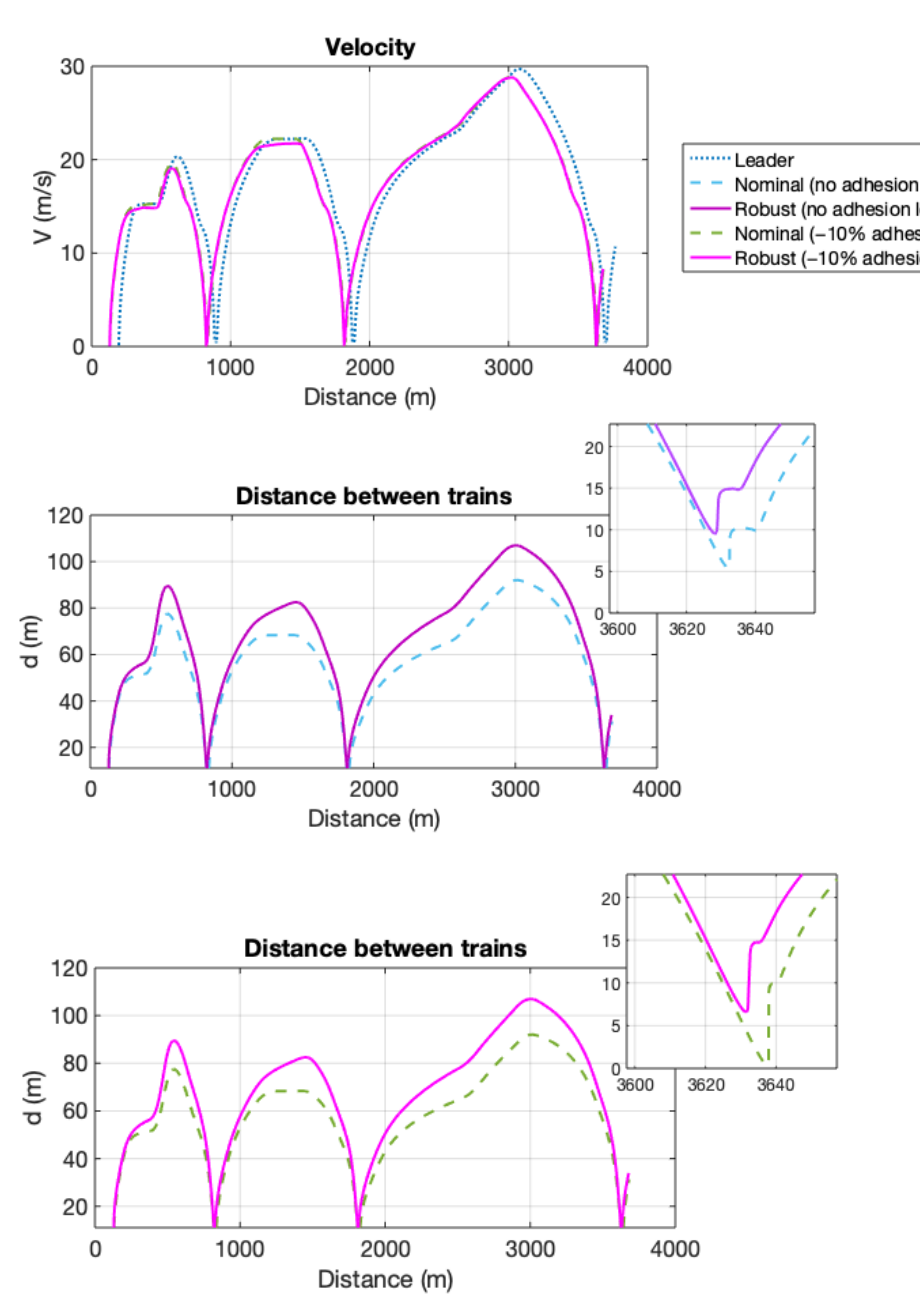
Figure 5. Results of simulation 1: 10% adhesion loss. Variables versus distance travelled.